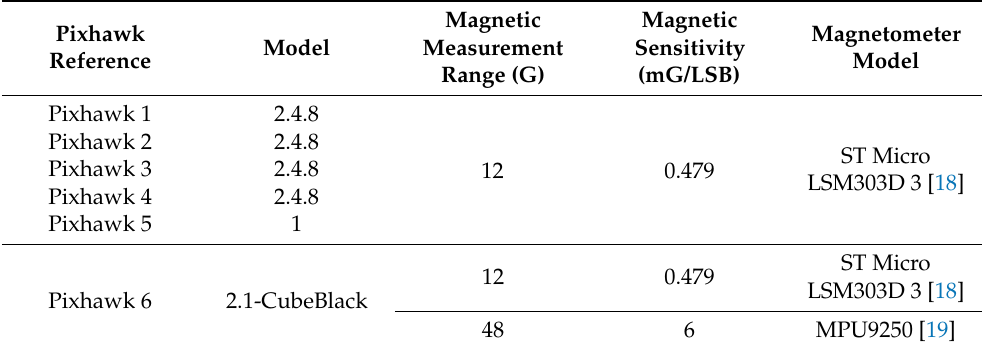
Table 1. Pixhawk and magnetometer sensor models. Pixhawks 1 to 4 are different units of the same